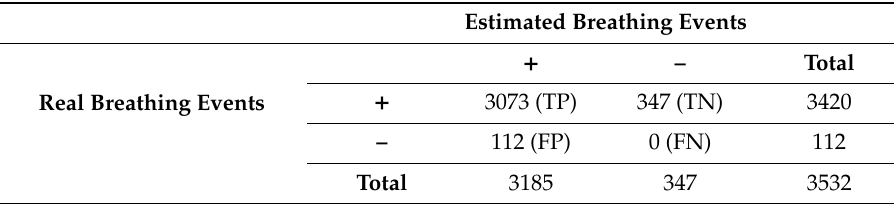
Table 1. Performance of the proposed method in detecting breathing events.